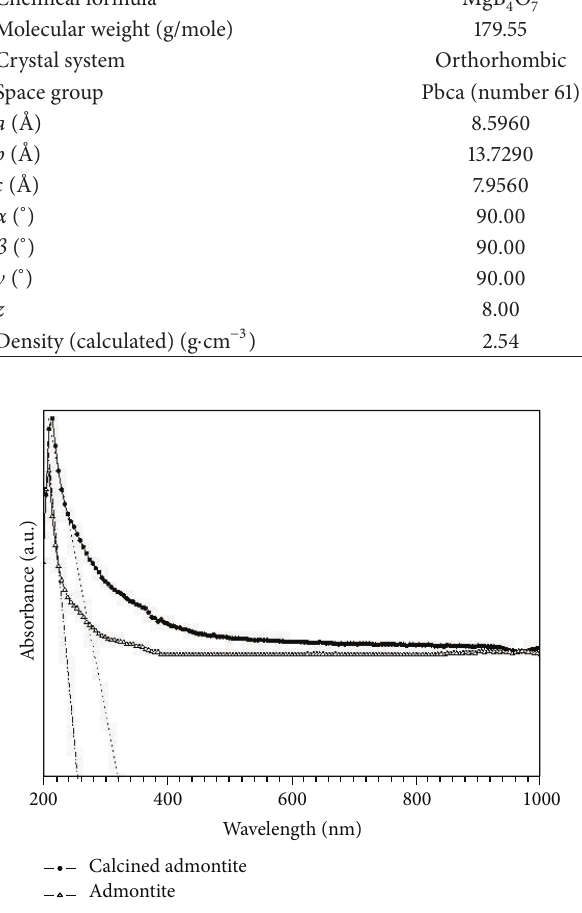
Figure 9: The optical absorption spectra of admontite and calcined admontite.